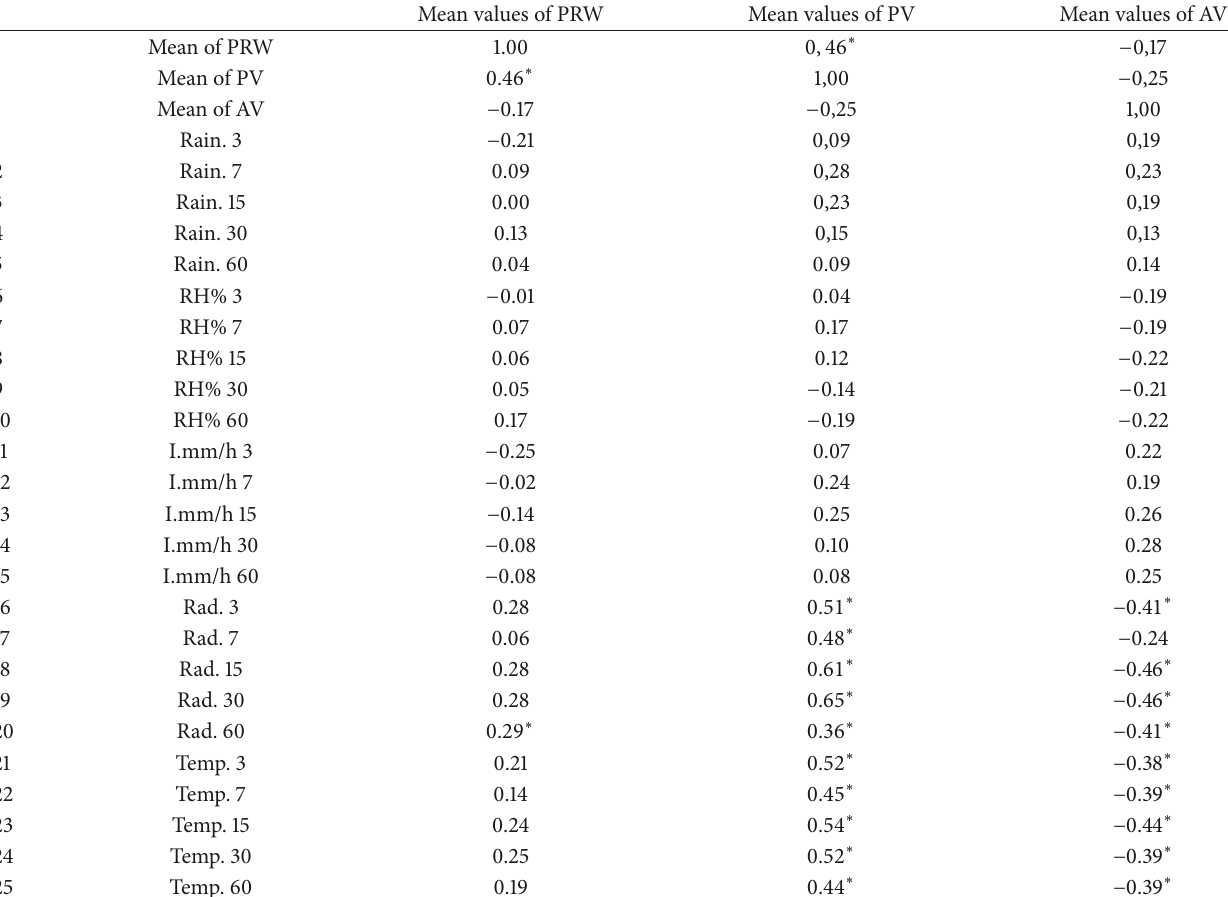
Table 8: Correlation matrix of the number of PRW, PV, and AV and weather variables in the first period (1998-1999). Mean values of PRW Mean values of PV Mean values of AV Mean of PRW